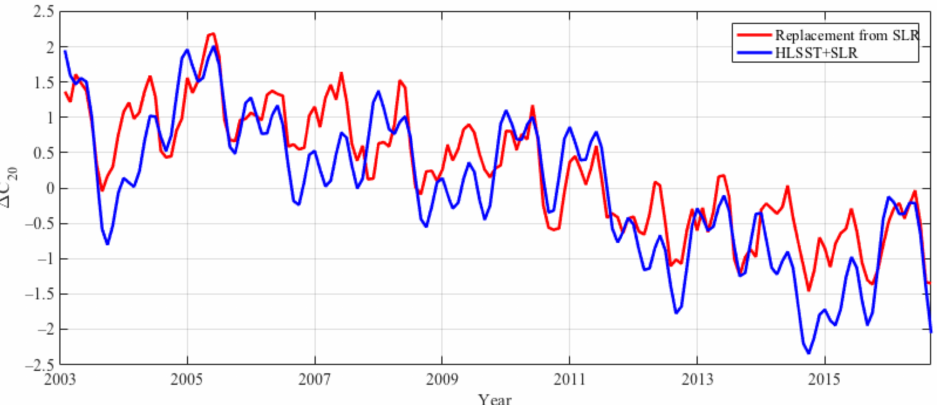
Figure 5. Spherical harmonic coefficient C 20 variation of HLSST+SLR solutions and the replacement value from SLR for GRACE CSR solutions covering period from January 2003 to August